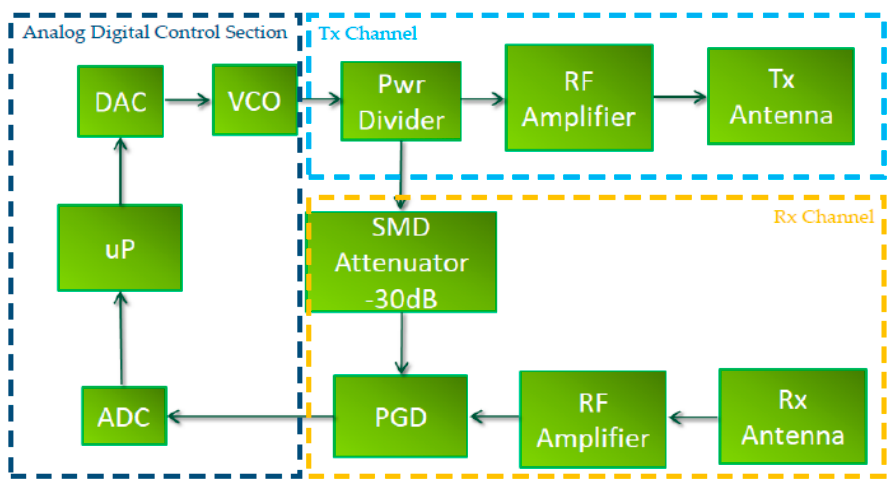
Figure 1. Architecture of the portable reader for frequency domain chipless tags.